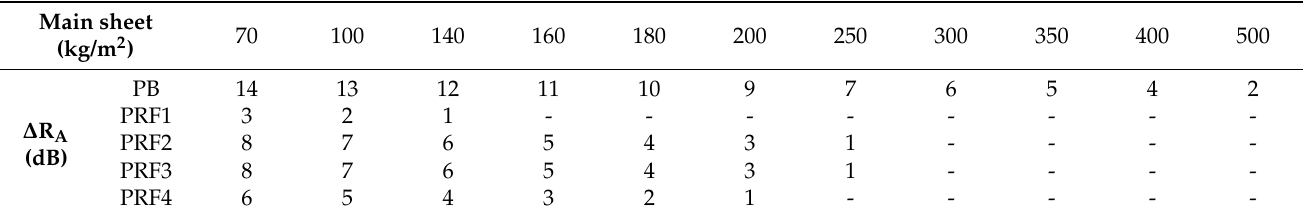
Table 4. Estimation of the sound reduction index improvement of additional layers, Δ R A (dB), from experimental data.